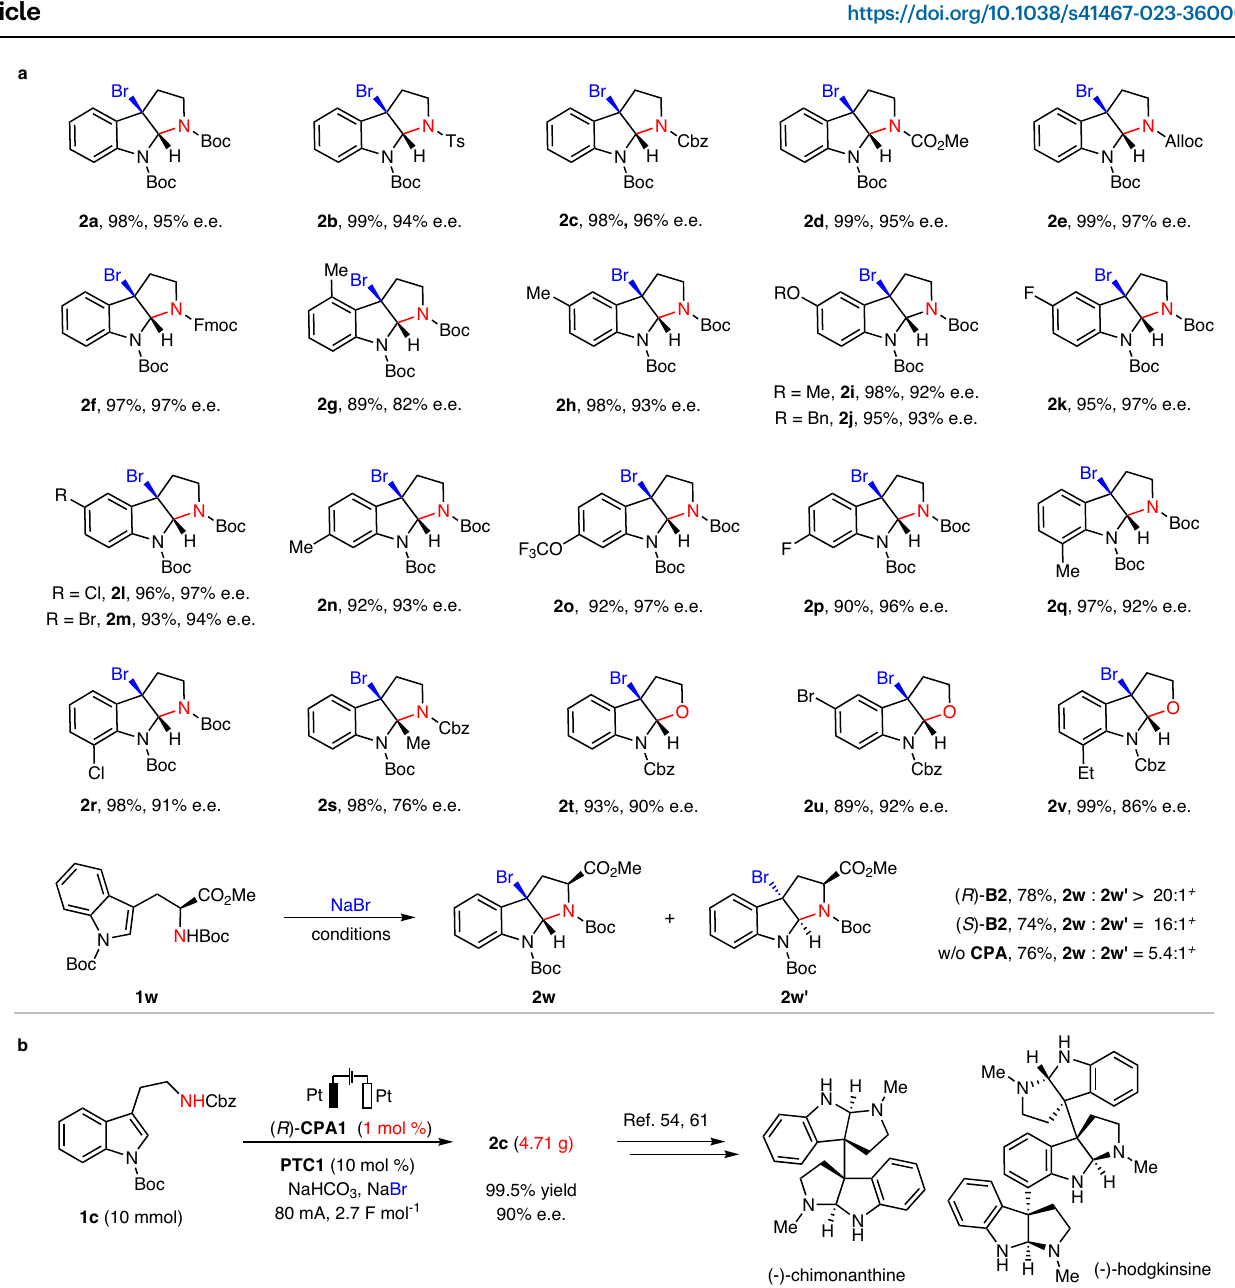
e.e. values were determined by chiral HPLC. Ts p -toluenesulfonyl, Cbz benzylox- ycarbonyl, Alloc allyloxycarbonyl, Fmoc 9- fl uorenylmethyl, Bn benzyl +